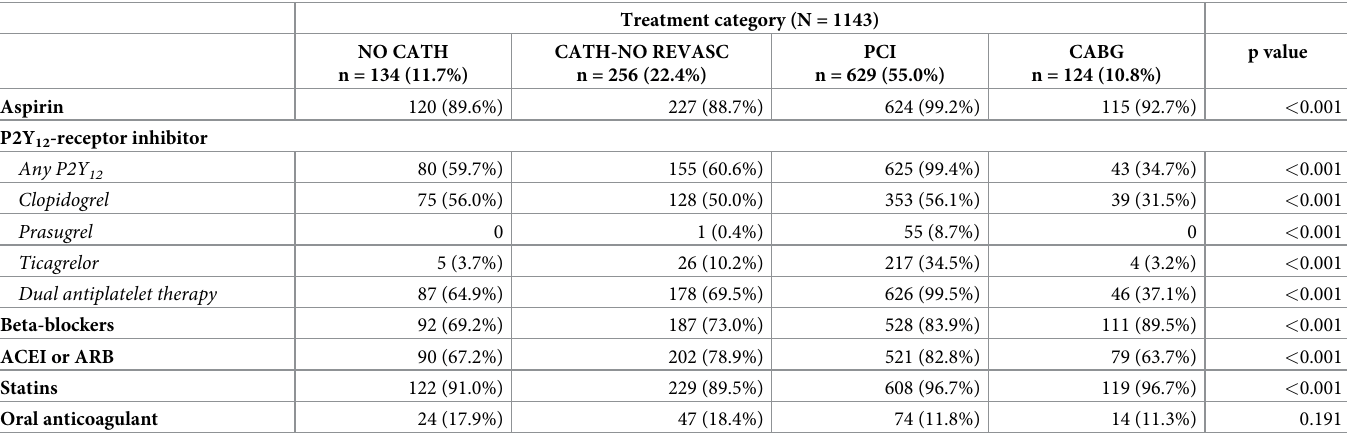
Table 3. Treatment at